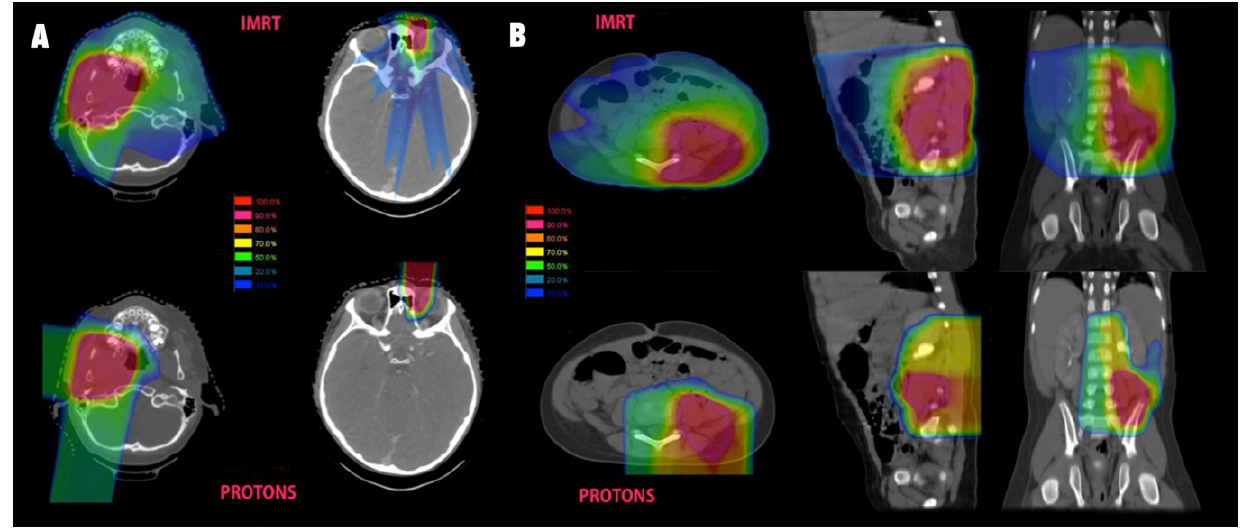
Figure 2. Isodose comparisons for photon and proton plans. ( A ) Typical parameningeal (left) and orbital (right) plans for pediatric RMS. IMRT plans are shown above and proton plans for the same patient seen below; ( B ) A pelvic sarcoma with comparative photon and proton plans shown in three